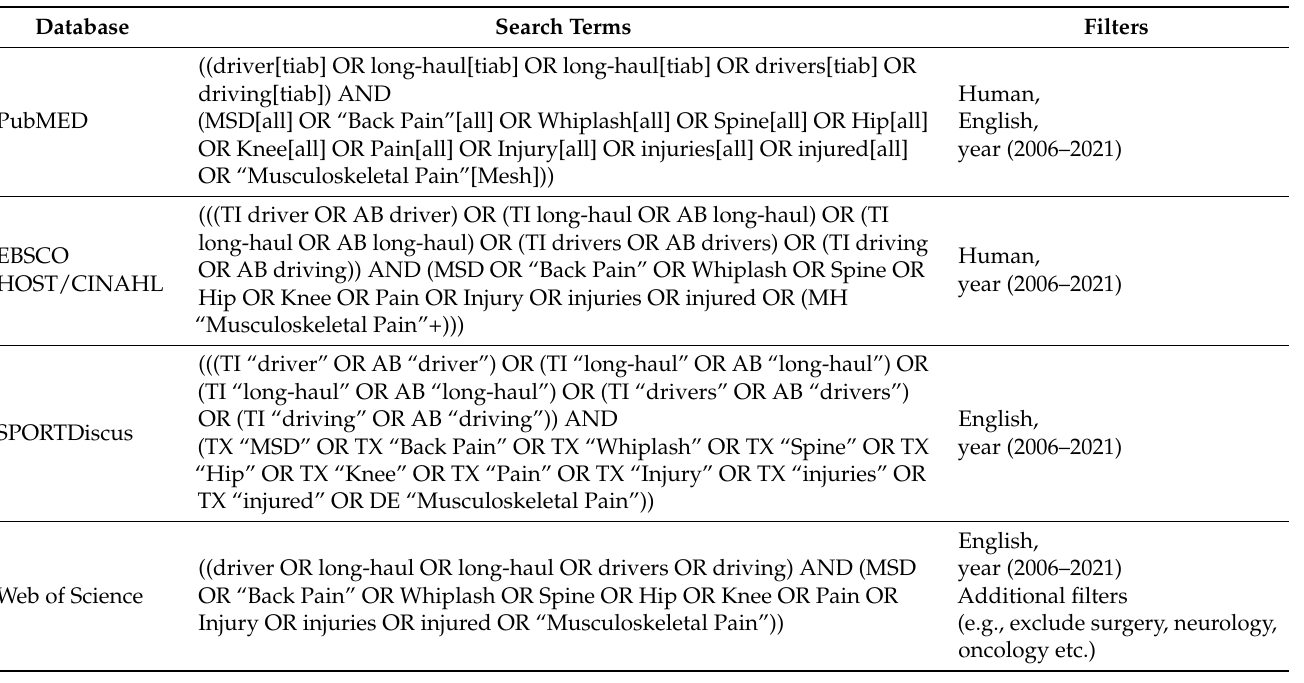
Table 1. Database and relevant search